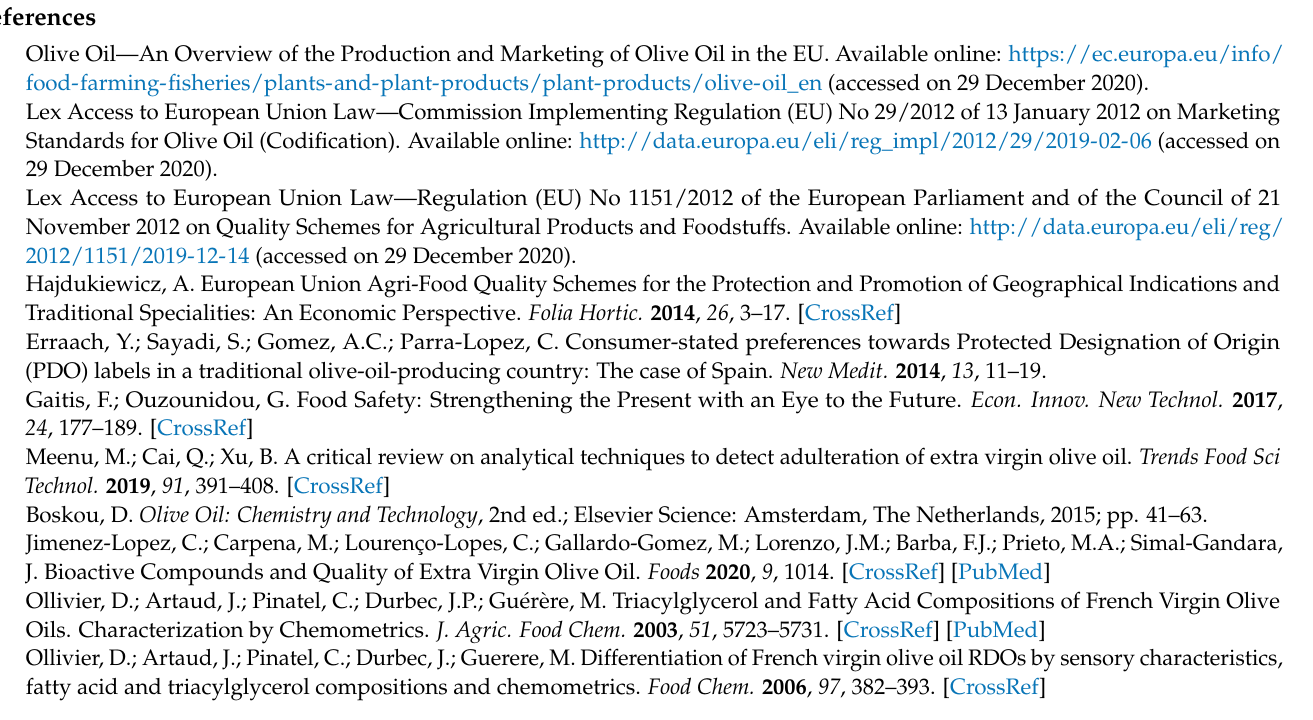
coefficients for the absorption predictive model, Figure S4: Loadings derived from PCA for absorption data, Figure S5: Samples from (a) Peloponnese, (b) Crete, (c) Lesvos, and (d) Lesvos–Crete